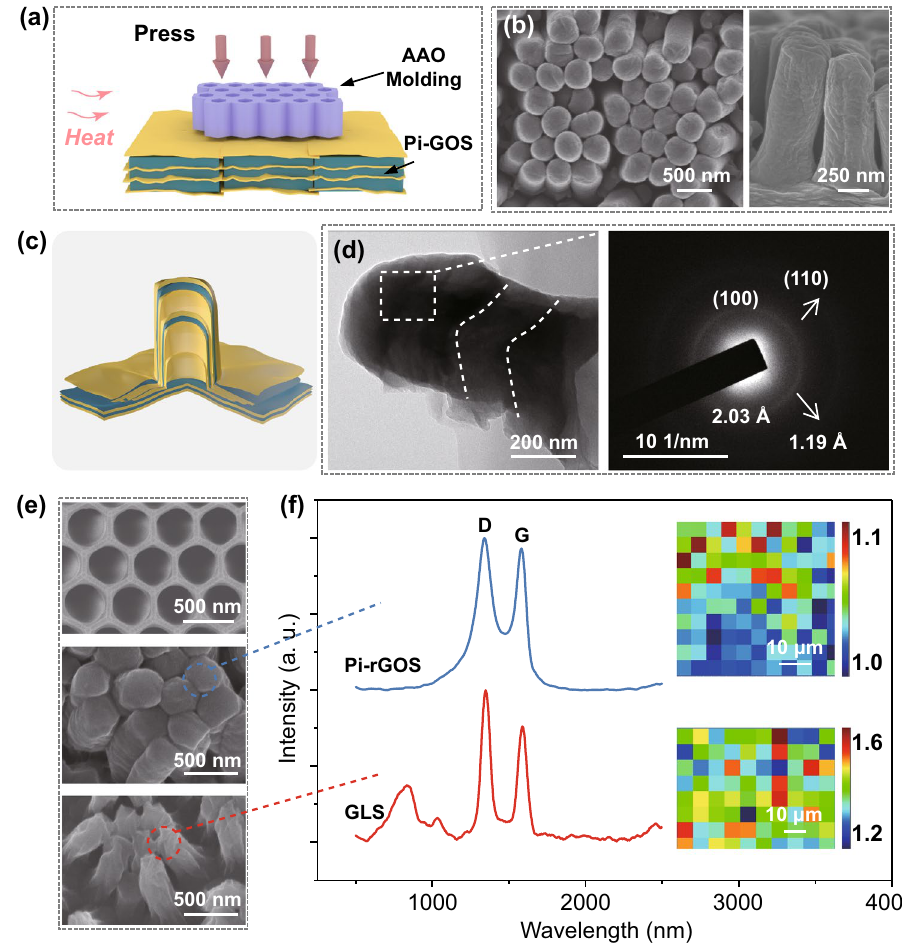
Fig. 6 a Schematic diagram of thermal nanoimprinting process with through-hole AAO template. b SEM observations, c structural representa- tion and d TEM images of the exterior and interior manufacture of nanorods. e SEM images of AAO template (top), imprinted Pi-rGOS nano- pillars (middle) and heat reduced GLS nanopillars (bottom). f Raman spectra of Pi-rGOS and GLS. The insets are Raman mapping analysis of Pi-rGOS (up) and GLS (bottom) by considering the intensity ratio of D and G